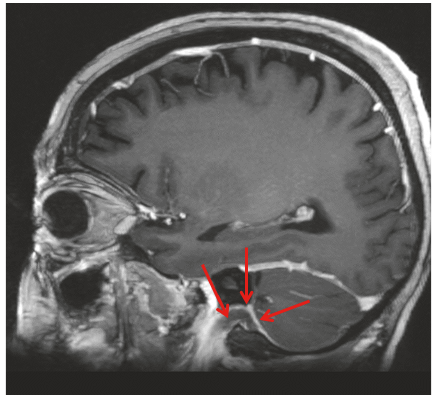
Figure 4: Sagittal reformatted postcontrast FSPGR images demon- strating filling defect within the left sigmoid sinus and proximal jugular vein. Arrow demonstrates thrombus within the distal sig- moid sinus and internal jugular